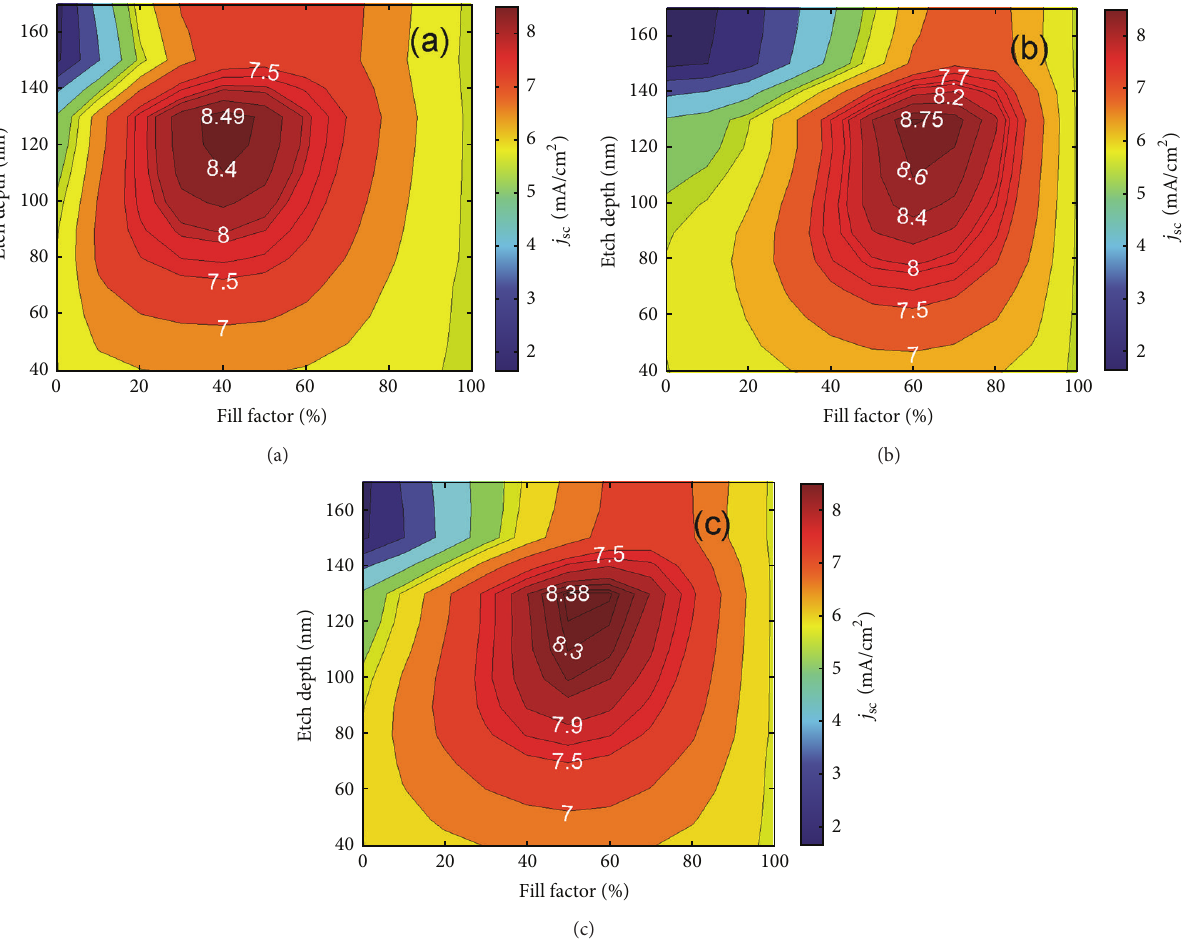
Figure 3: Calculated short-circuit current density for an optimized solar cell structure with a 20 nm-thick InGaN layer and 𝑎 = 300 nm. The incident light is (a) parallel and (b) perpendicularly polarized to the photonic crystal pattern. (c) For unpolarized